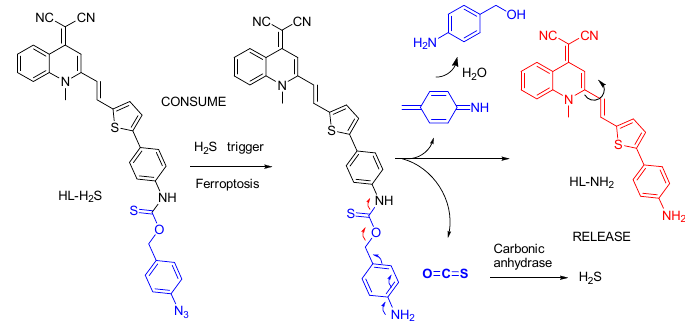
Figure 15. The H 2 S − triggered NIR fluorescence response and H 2 S release mechanism of HL − H 2 S [71].